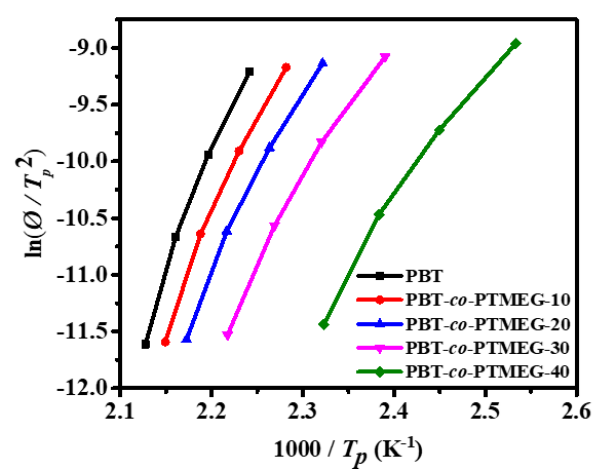
Figure 10. Plots of ln( ∅ / T p2 ) versus 1000/ T p for PBT and PBT- co -PTMEG copolymers.